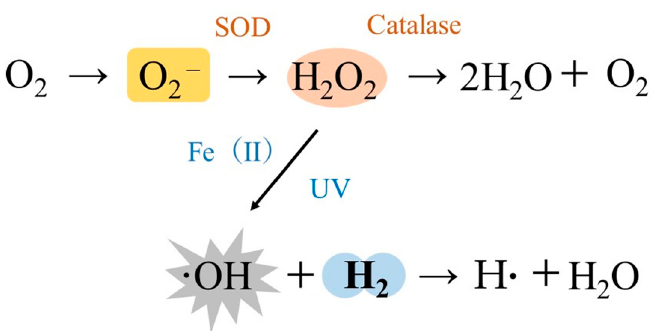
Figure 1. Selective action of molecular hydrogen (H 2 ). Superoxide anion (O 2 − ) is produced from oxygen that leaks from the mitochondrial electron transfer system. O 2 − is further converted into hydrogen peroxide (H 2 O 2 ). However, when water molecules are irradiated with ionizing radiation or H 2 O 2 is irradiated with UV light, hydroxyl radicals (·OH) are produced. H 2 can scavenge and detoxify the large amounts of ·OH produced in the mitochondria and other organelles by converting it into water molecules (·OH + H 2 → H· + H 2 O).